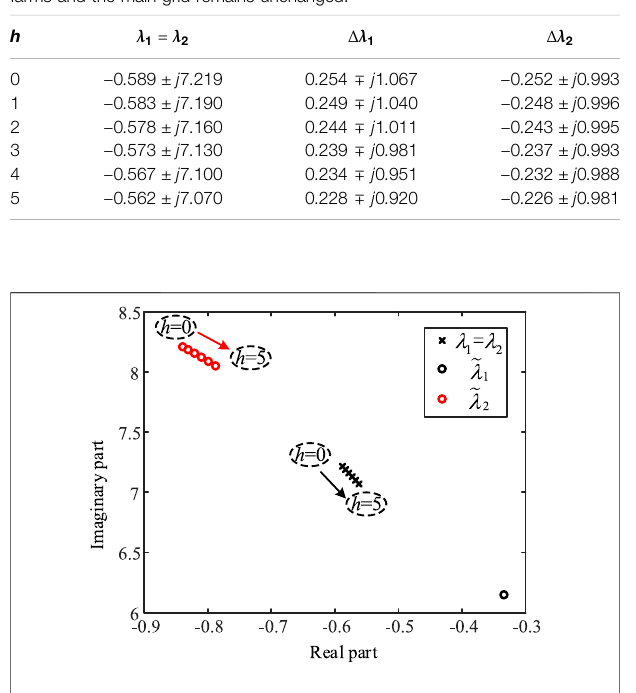
FIGURE 15 | Trajectories of the open and closed-loop mode when the electrical distance between each of the PV farms and the main grid remains unchanged.